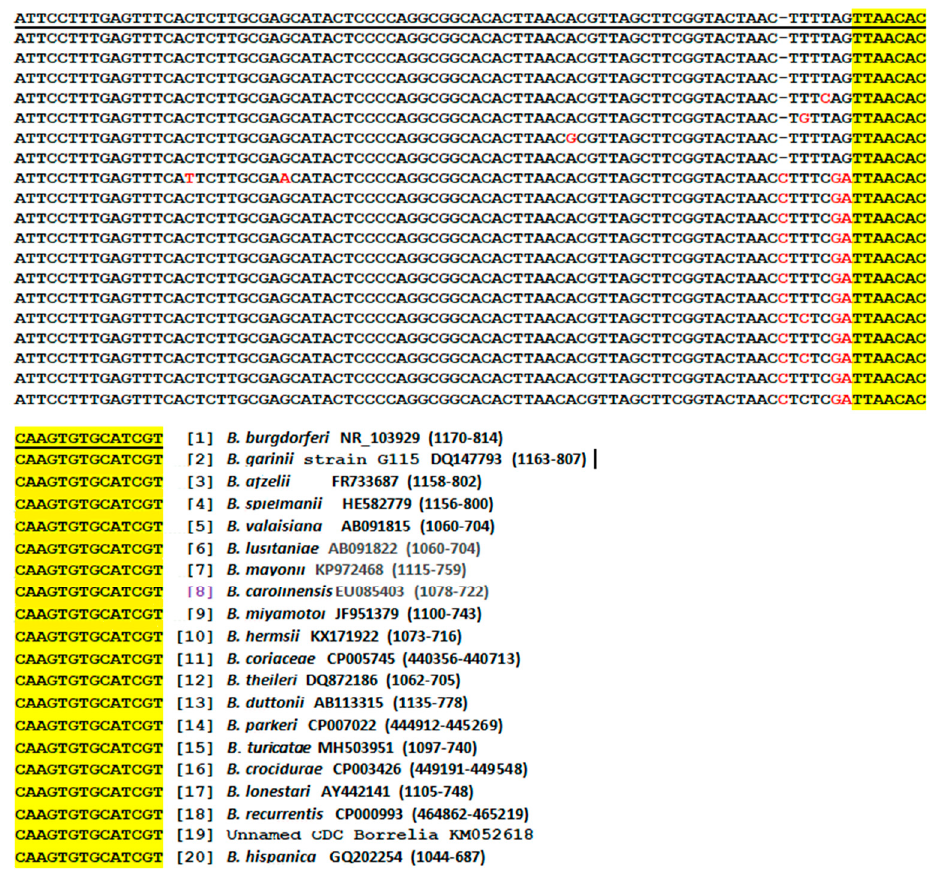
Figure 1. Alignment of 20 highly conserved 357 / 358-base borrelial 16S rRNA gene segments defined by the M2 and M1 primer sites (yellow-highlighted) with variable regions (typed in red letters). Sequences retrieved from the GenBank database with sequence ID# listed at the end after the M1 primer site. Note: B. = Borrelia.